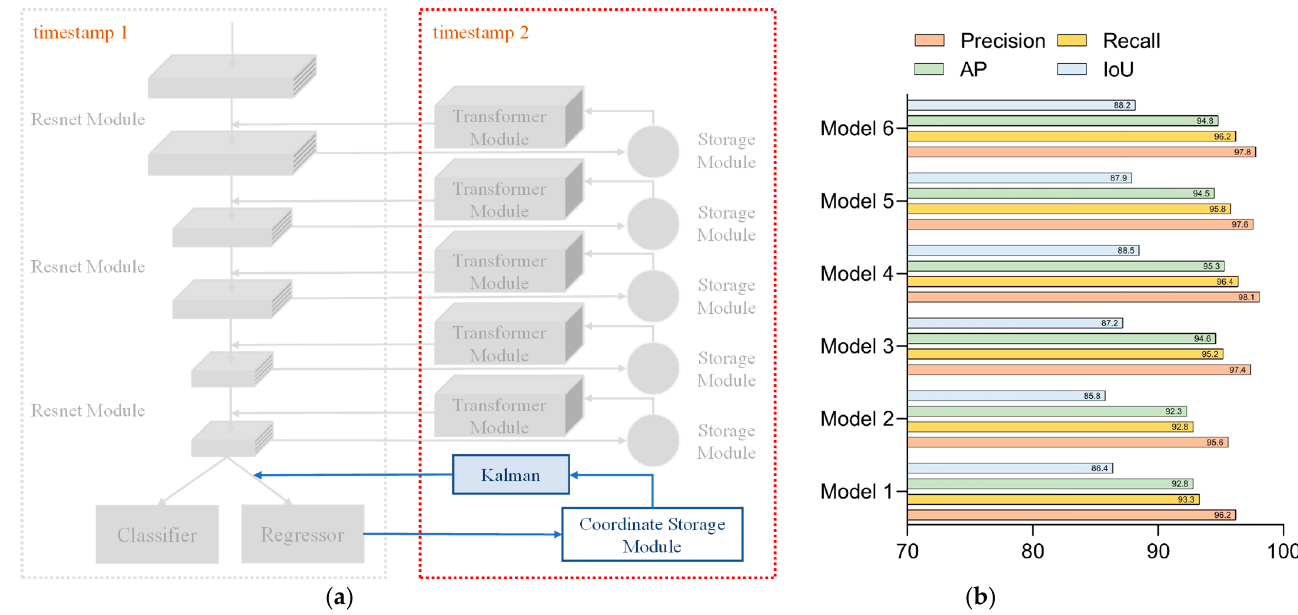
Figure 12. Network 5: ( a ) configuration of Network 5 and ( b ) test results for each parameter of Network 5.